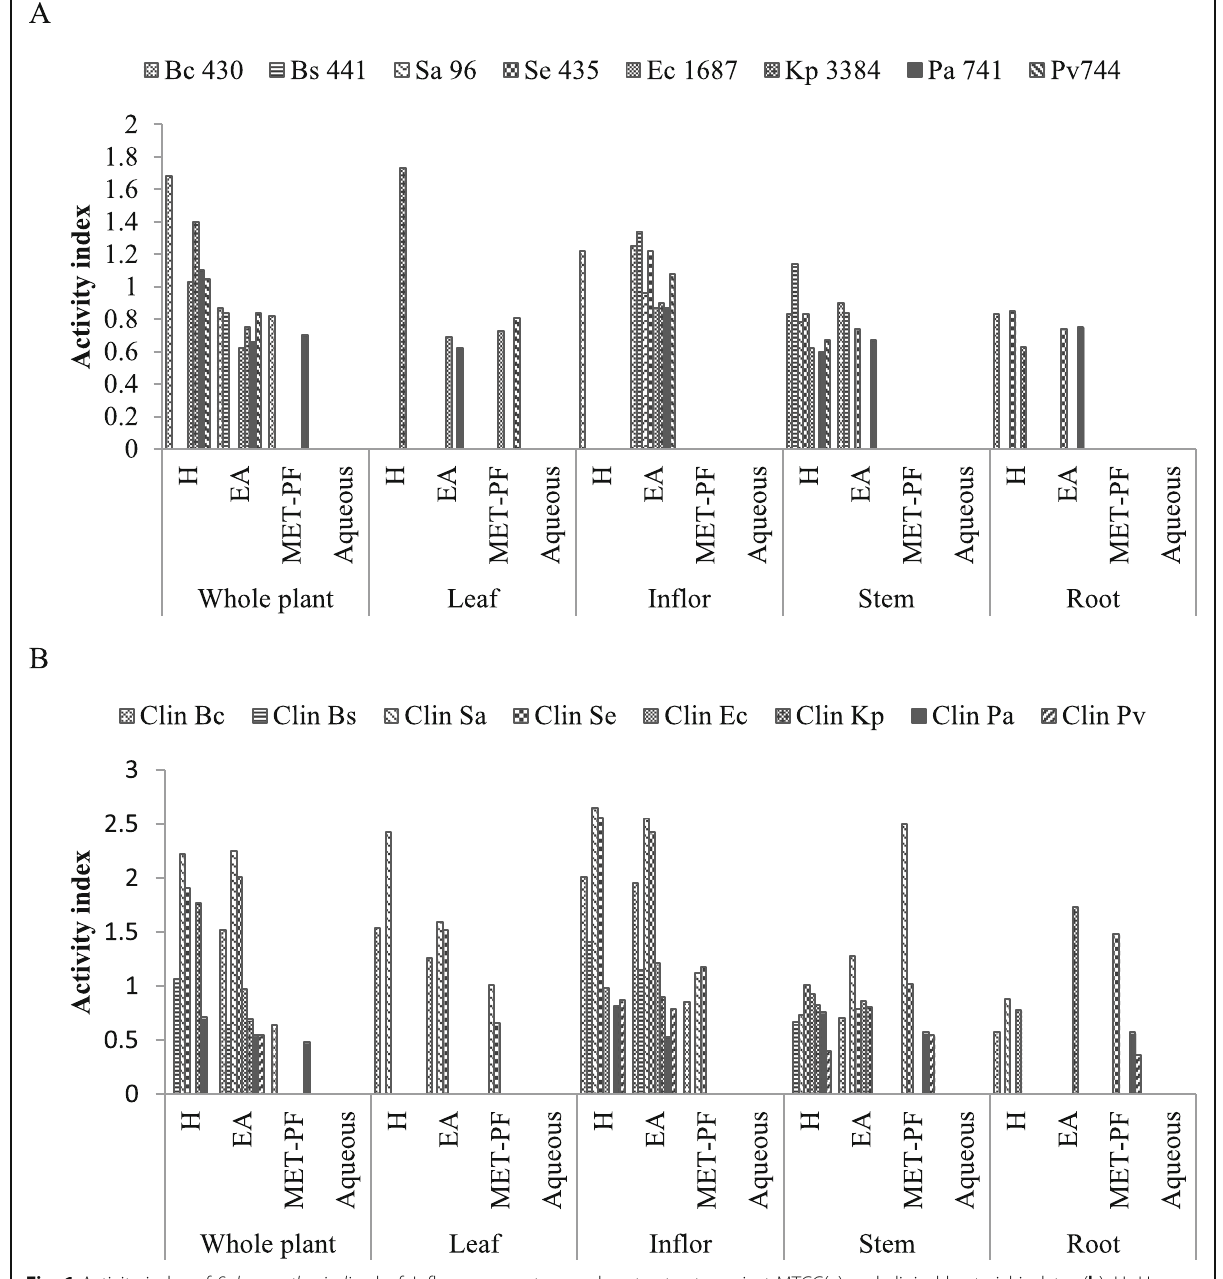
Fig. 1 Activity index of Sphaeranthusindicus leaf, Inflorescence, stem and root extracts against MTCC( a ) and clinical bacterial isolates ( b ). H- Hexane extract, EA- ethyl acetate extract, MET-PF – Methanol polar fraction. Bc – B. cereus , Bs – B. subtilis , Sa – S. aureus , Se – S. epidermidis , Ec – E. coli , Kp – K. pneumonia , Pa – P. aruginosa , Pv – P.